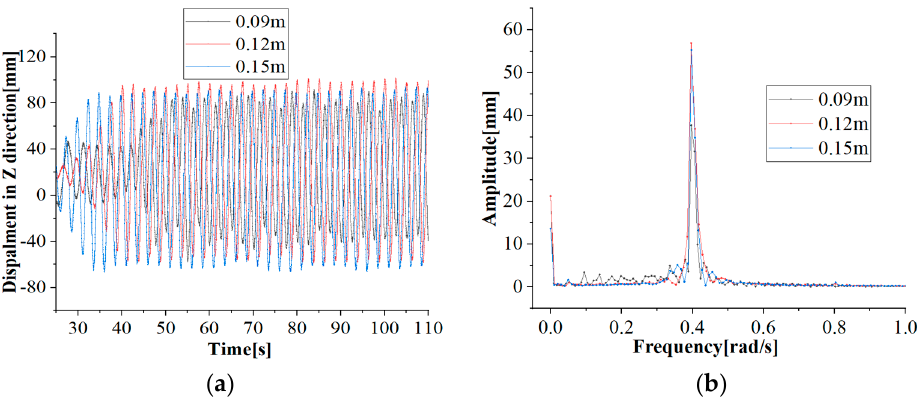
Figure 23. Heave response of the pedestal with different wave heights at 0.40 Hz. ( a ) Heave; ( b ) heave frequency domain curve.